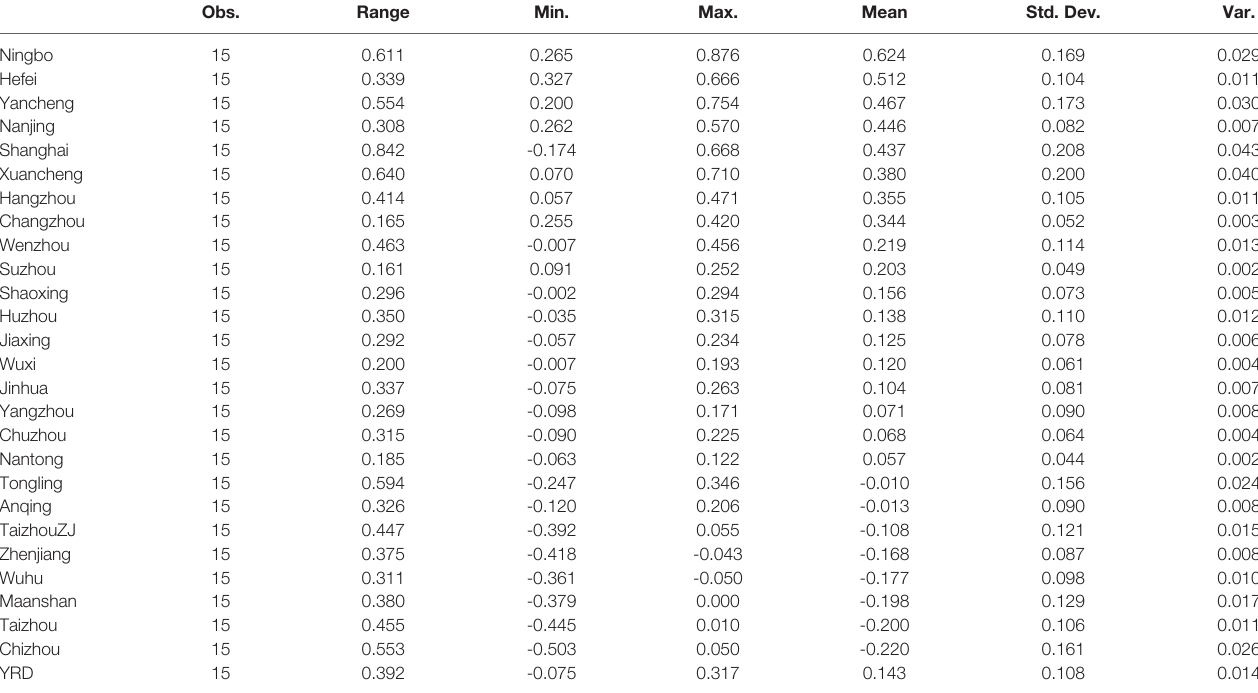
TABLE 1 | Descriptive statistics of UHI intensity in Cities of YRD (2003 to 2017). Obs. Range